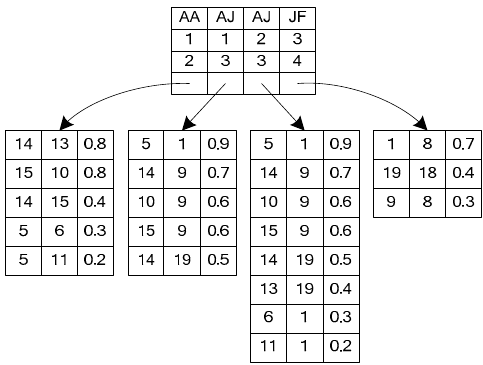
Figure 6. The candidate edge set of Q in Figure 2.